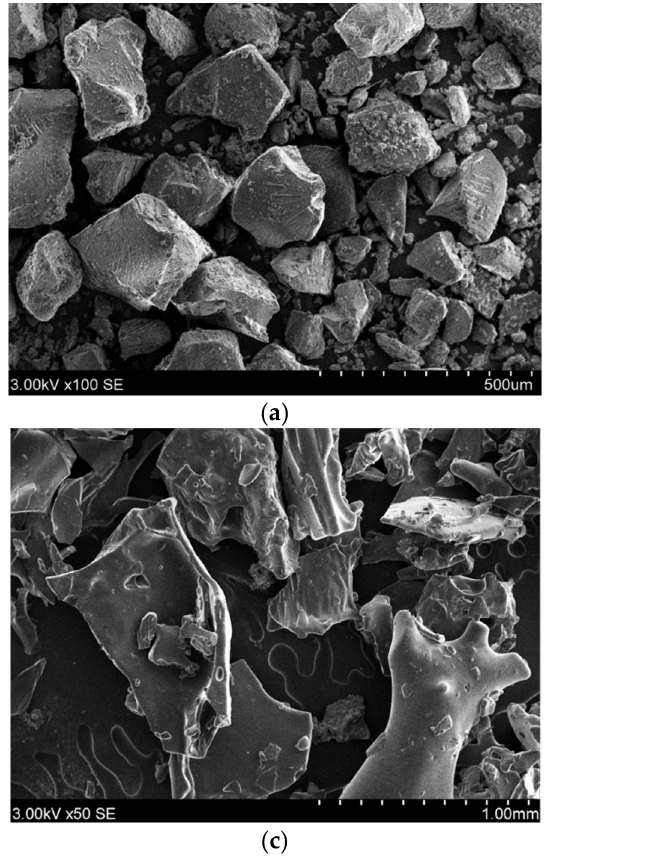
Figure 2. SEM images of common buckwheat spent grain before enzyme-assisted extraction ( a ) and after enzyme-assisted extraction ( b – d ). The images are at a scale bar of 1.00 mm and 500 μ m.